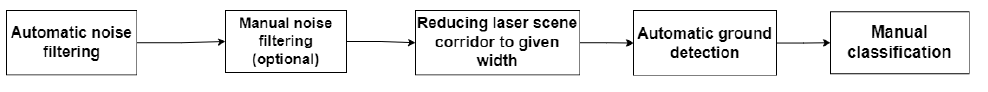
Figure 3. Simplified input data preparation